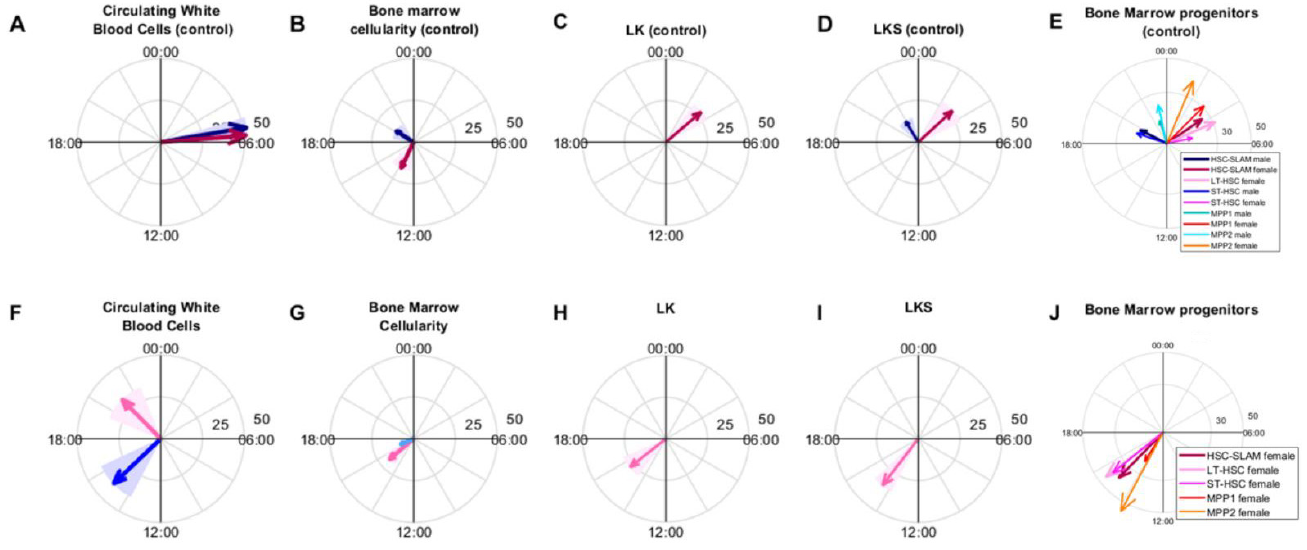
Figure 7. Polar plots of circadian rhythms in key components of the hematopoietic system in control conditions ( A – E ) and under oxaliplatin treatment ( F – J ). Blue colors refer to males and pink colors to